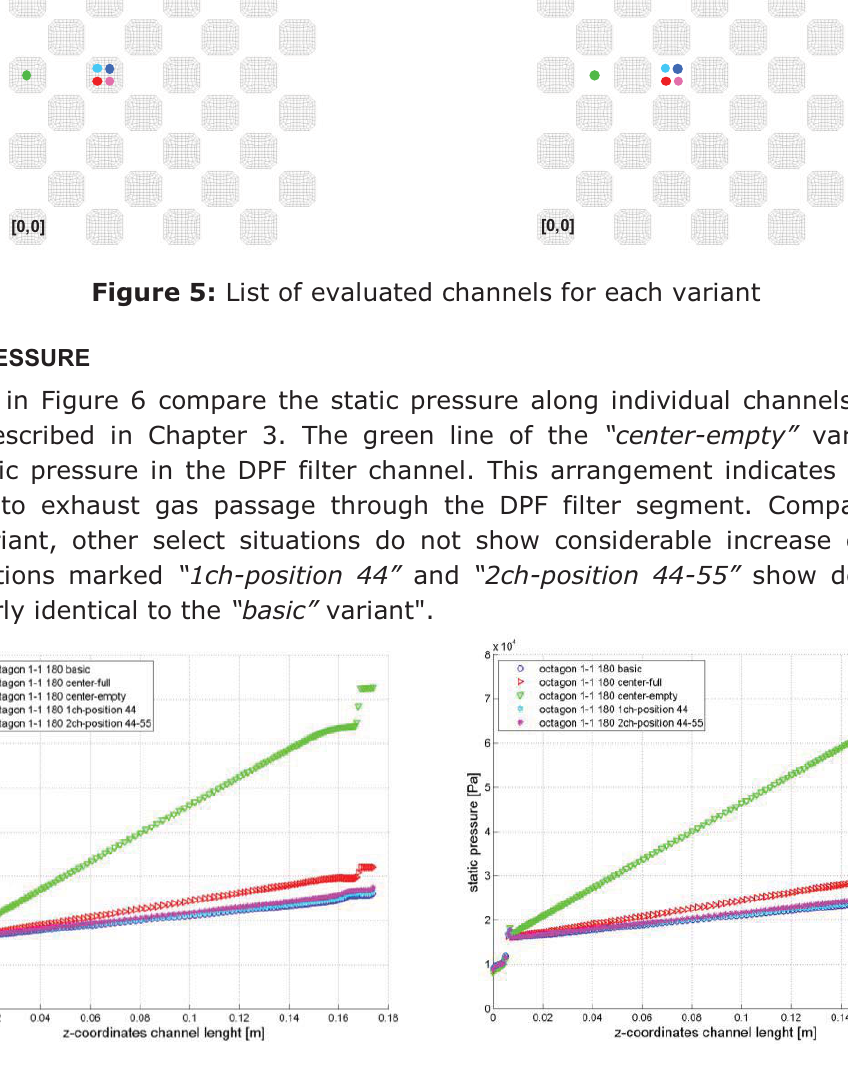
Figure 6: Static pressure development in the open and closed